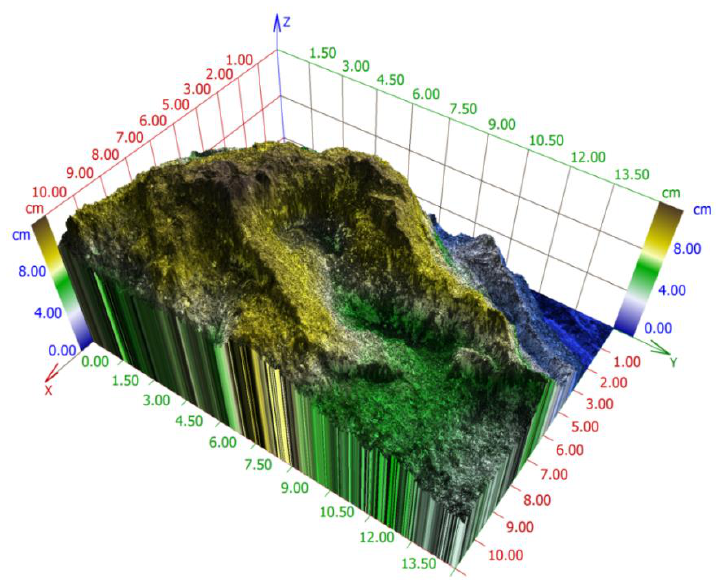
Figure 16. A 3D reconstruction of the blue marble sample by data registration according to Section 4, with focusing criterion (28) and profile height calculations (29) and (30). The software was written by the first author. Taken from [45].